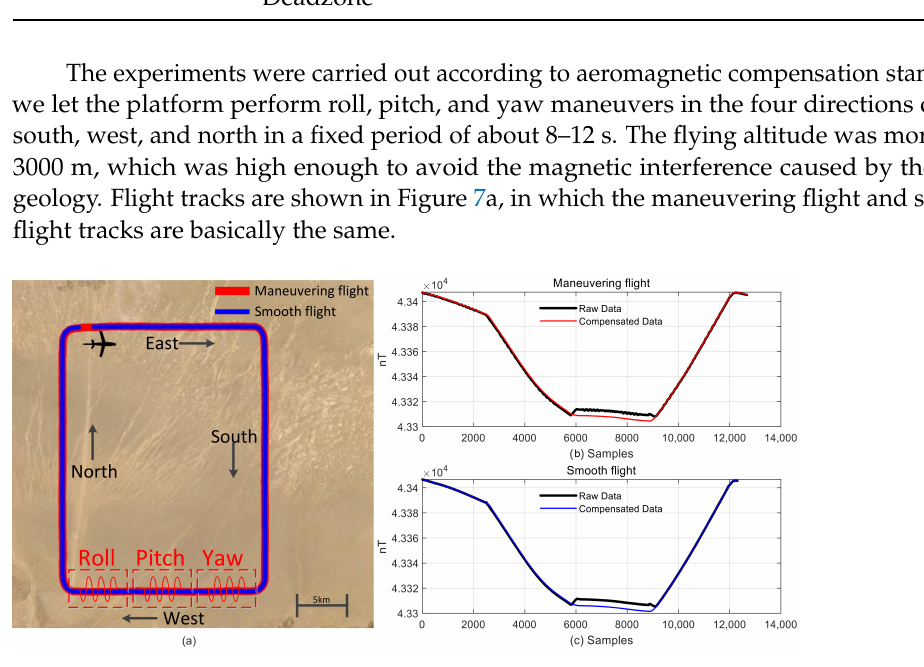
Figure 7. Flight track and compensation results of the proposed method. ( a ) Flight track of maneu- vering flight and smooth flight. ( b ) Raw data and compensated data of maneuvering flight. ( c ) Raw data and compensated data of smooth